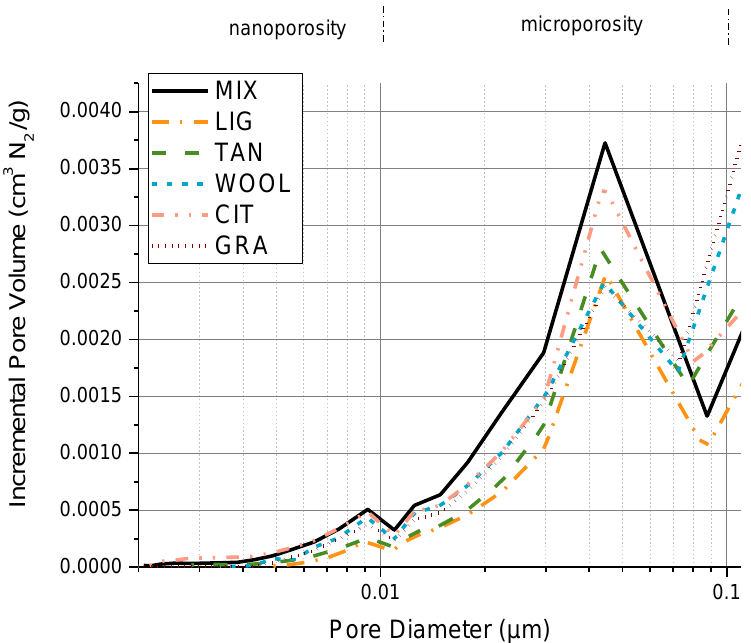
Figure 7. Incremental pore volume with respect to the pore diameter.